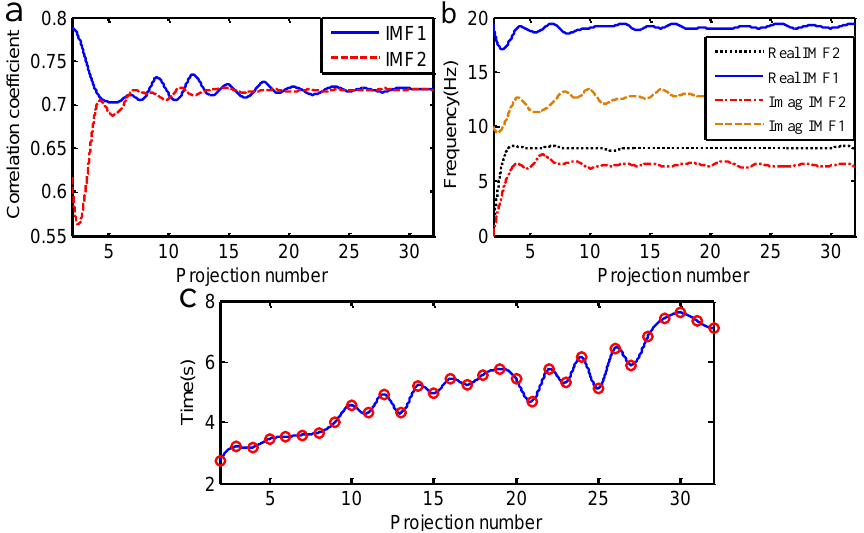
Figure 6. Marginal spectrum of simulated chatter signal.